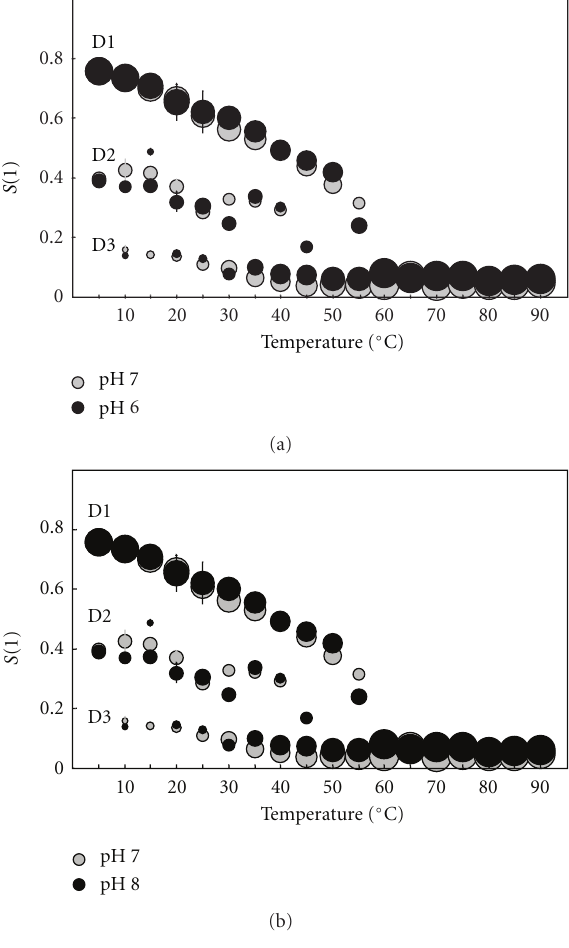
Figure 8: Temperature dependence of the order parameters ( S ) and proportions of MeFASL(10,3) in the membrane regions of the SUV archaeosomes prepared from the PLMF from A. pernix grown at pH 6.0 (black circles) and 7.0 (grey circles) (a), and at pH 7.0 (grey circles) and 8.0 (black circles) (b). The diameters of the symbols indicate the proportions of each region. D1, D2, and D3 indicate the regions with the highest, intermediate-and lowest- order parameters, respectively. Experiments were performed at pH